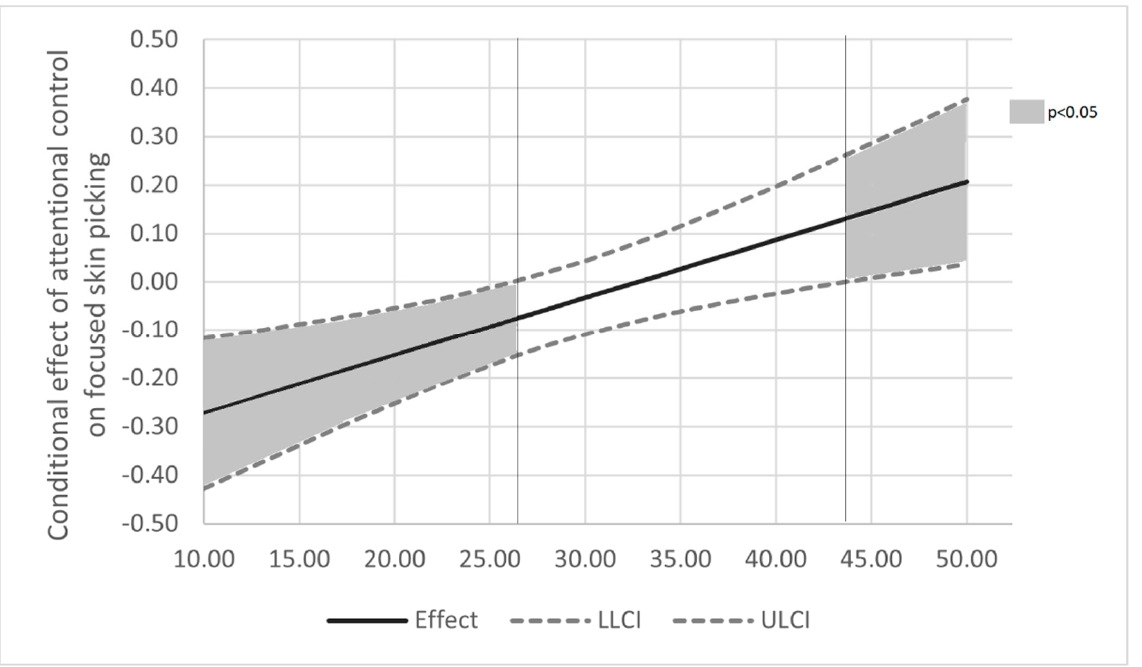
Figure 2. The Johnson–Neyman graph for the model relating focused skin picking to attentional control, negative affectivity and their interaction. Note: The effect of attentional control on focused skin picking is negative and significant for lower levels of negative affectivity (<26.25) and positive and significant at high levels of negative affectivity (>43.71). Gender, age and positive affectivity were controlled for in the analysis. Additional analyses conducted separately for women and men can be found in Supplementary Materials (Figures